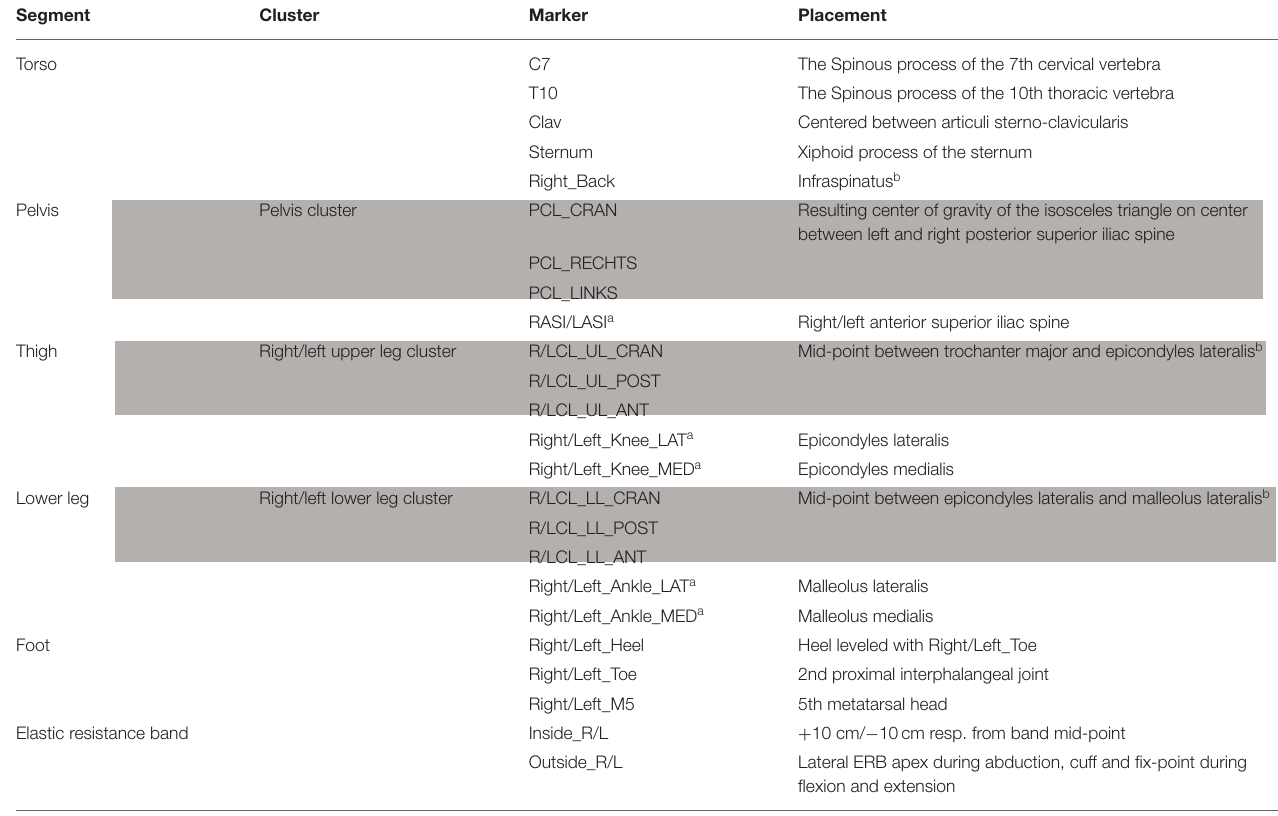
TABLE 2 | Marker set used for collecting the movement of our participants. Segment Cluster Marker Placement Torso